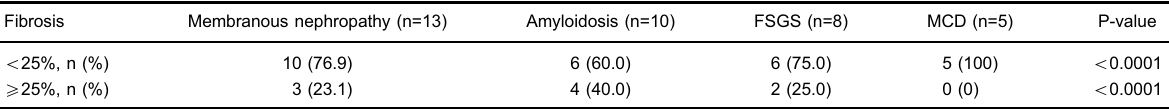
Table 2. Proportional distribution of interstitial fi brosis ( o 25% or X 25% of the parenchyma) among patients over 65 years of age with nephrotic syndrome by etiology. Fibrosis